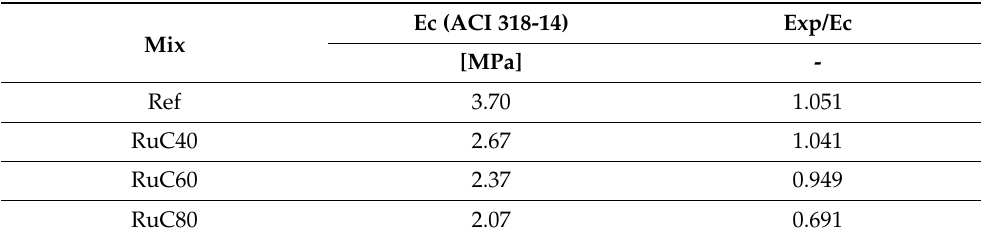
Figure 13. Tensile splitting strength of Ref and RuC mixes. Table 5. Predicted values for the tensile splitting strength as function of the compressive strength.